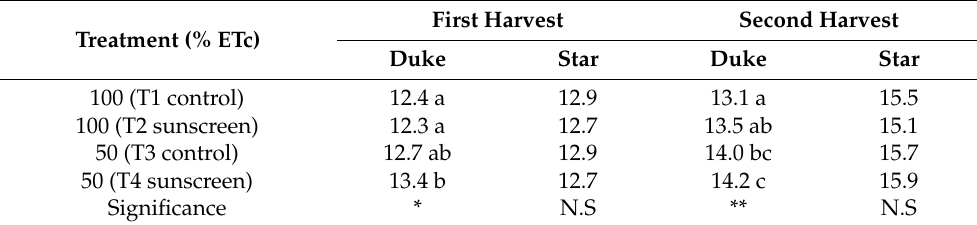
Table 8. Total soluble solids ( ◦ Brix) at the first and second harvest of blueberry plants in the performed treatments on the Duke and Star